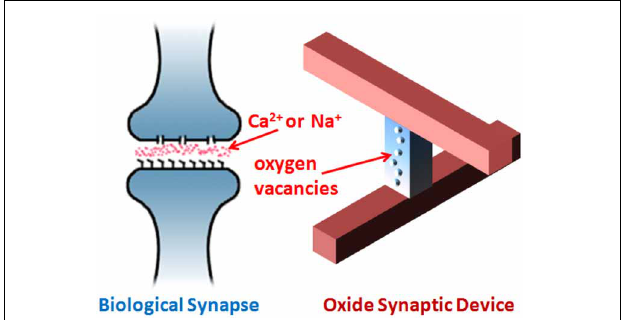
FIGURE 1 | An analogy between the biological synapse and the arifitial oxide synaptic device. The biological synapse changes its conductance by activating/deactivating ion channels between the membrane and the synaptic junction when the action potential arrives from pre-synaptic and post-synaptic neurons coherently, while the oxide synaptic device changes its resistance by generation and migration of the oxygen vacancies when the programming voltage pulse that is larger than the threshold is applied. The neural network is emulated by the cross-point oxide synaptic device